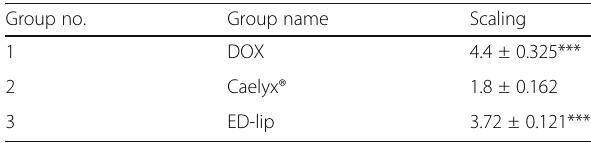
Table 2 Scaling of formulation cell uptake based on doxorubicin fluorescent color Group